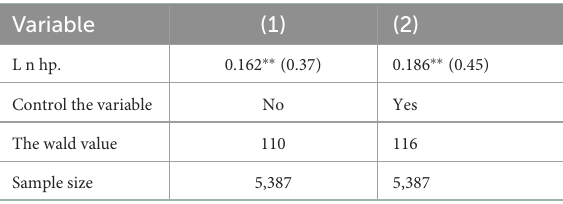
TABLE 6 Double-hurdle model of housing prices affecting the FLP